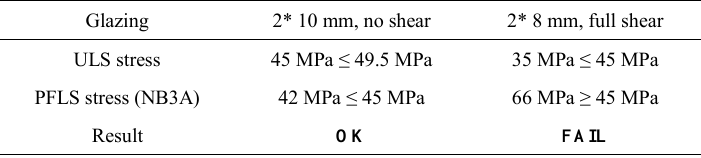
Table 1: Stress calculation for simplified barrier glazing example